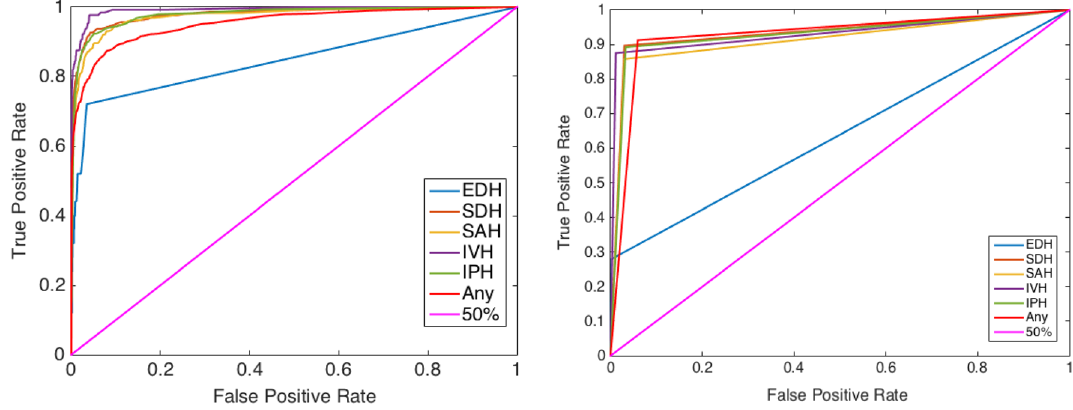
Figure 4. Receiver operating characteristic (ROC) curves using the external set by ( a ) generated probabilities per ICH type and ( b ) generated decisions after applying thresholds.